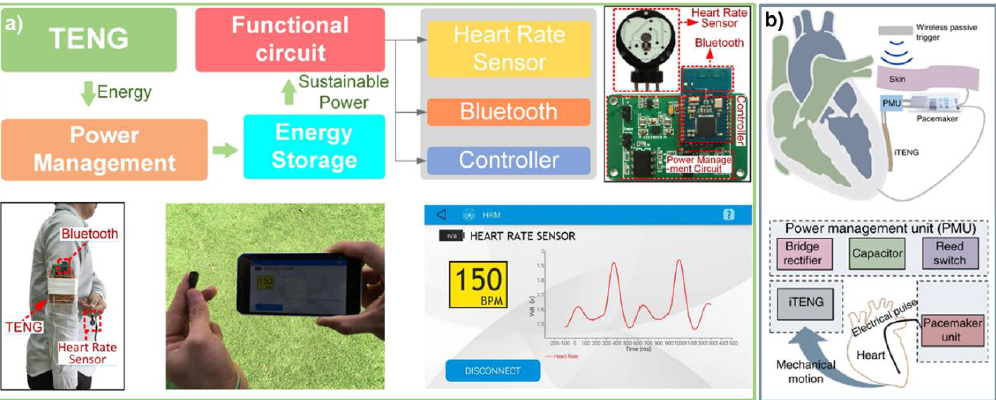
Figure 4 Examples of complete TENG powered systems. ( a ) A downy-structured TENG is used in a system where a capacitor is charged by a wearable device, and used to power a sensor, controller, and communication system [72]. ( b ) An implanted triboelectric pacemaker, including a controller and power management system, is powered by the heart motion [79]. Figures adapted from Lin et al. [72] and Ouyang et al. [80], respectively.